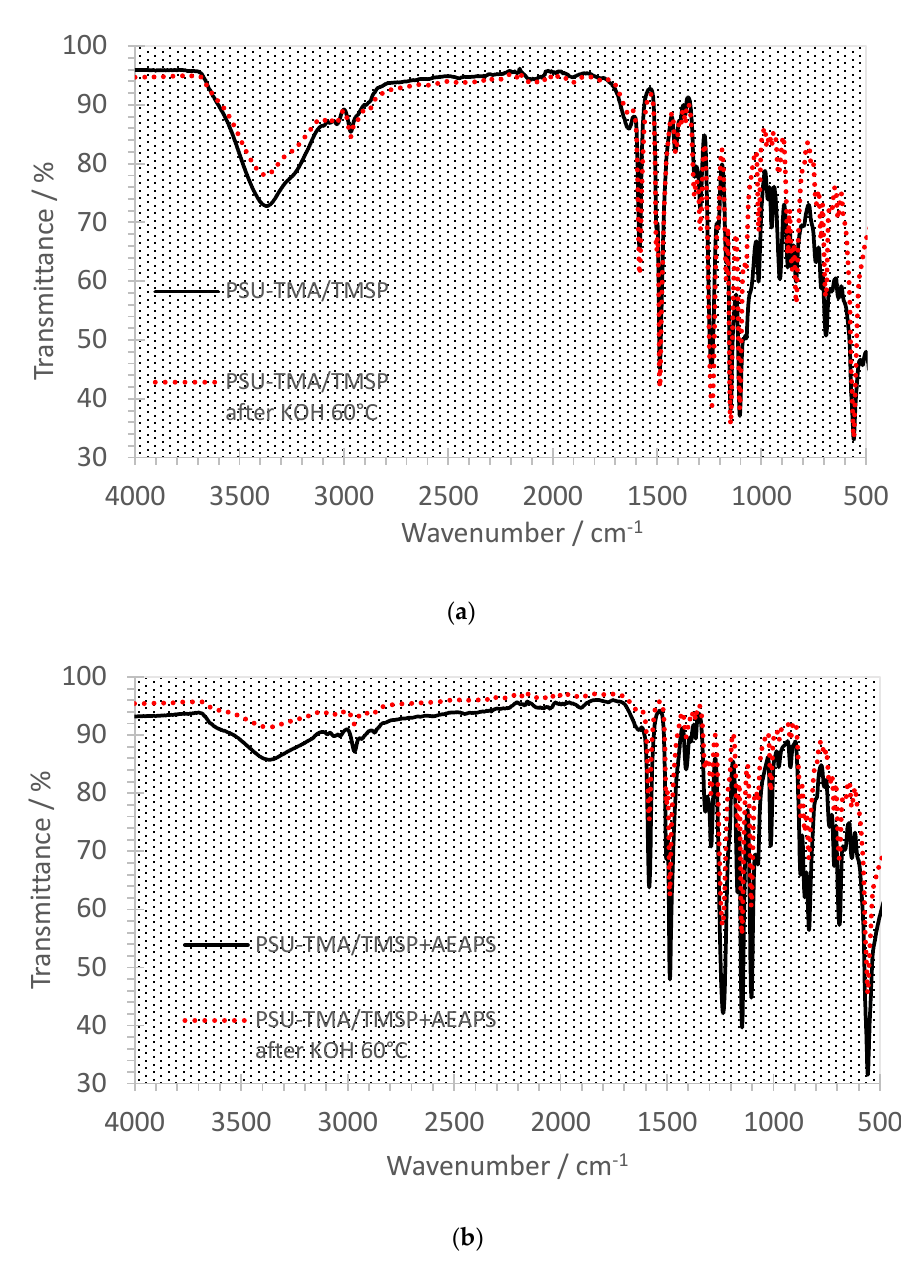
Table 2. Ionic conductivity of membranes. Conductivity mS/cm PSU-TMA/TMSP